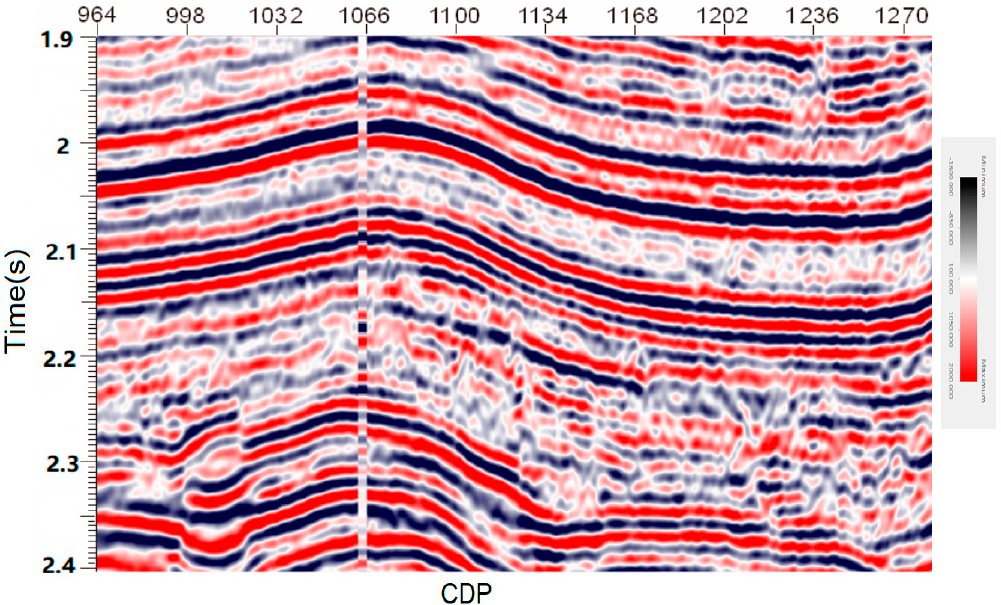
Figure 12. Field data extracted from well T3 (corresponding to the exploration line 299) located in the northern area of Yanmuxi in the Turpan Basin, west of China (data provided by courtesy of SINOPEC).